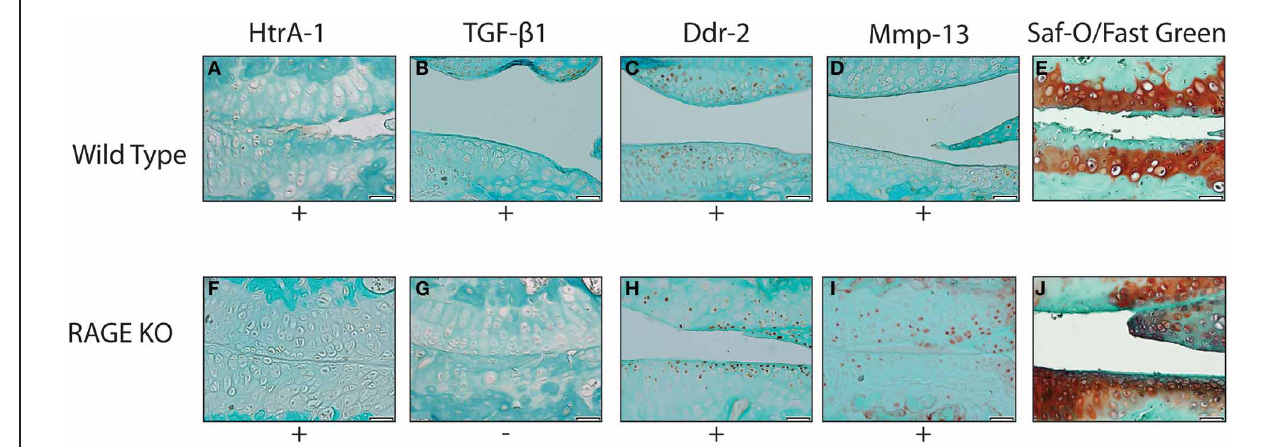
( n = 6) samples. The wild type and RAGE KO samples demonstrated similar staining patterns in all biomarkers except TGF- β 1 where the RAGE KO samples demonstrated fewer samples which stained positive. The difference was not statistically significant when tested with a Chi-Squared test ( p < 0 . 35). The scale bar, valid for every image, is 50 μ